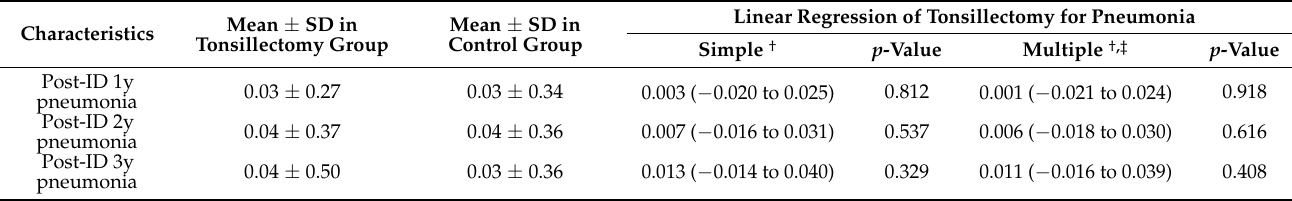
Table 2. Simple and multiple linear regression models (estimated value (95% confidence intervals)) for the post-index date of pneumonia (post-ID pneumonia) periods in the tonsillectomy group compared to the control group.